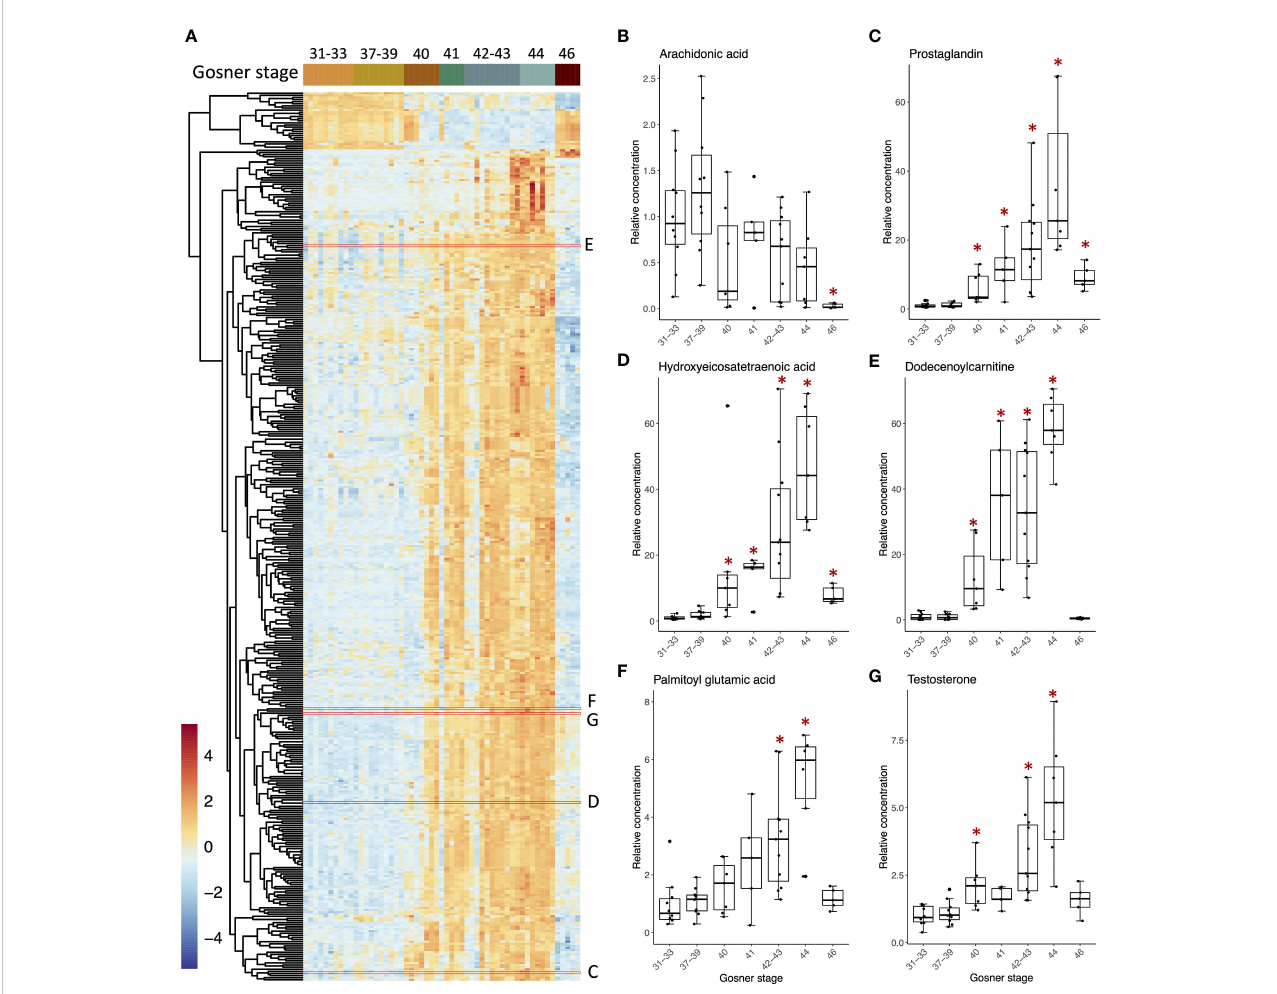
FIGURE 3 Heatmap (A) of 421 compounds that differed signi fi cantly in relative concentrations (ANOVA, adj p-value <0.05) between Gosner stage 44 and either stages 31-33 (premetamorphosis) or stage 46 (juveniles). Boxplots (B – G) showing examples of metabolites with their relative concentration plotted against the grouped Gosner stages. The positions of metabolites appearing in the heatmap with corresponding boxplots are outlined by red boxes. The relative concentration is found by normalizing peak areas to the average peak area for Gosner 31-33. Asterisks indicate signi fi cant difference from the premetamorphic Gosner stage 31-33 (Dunn ’ s post hoc test, p-value